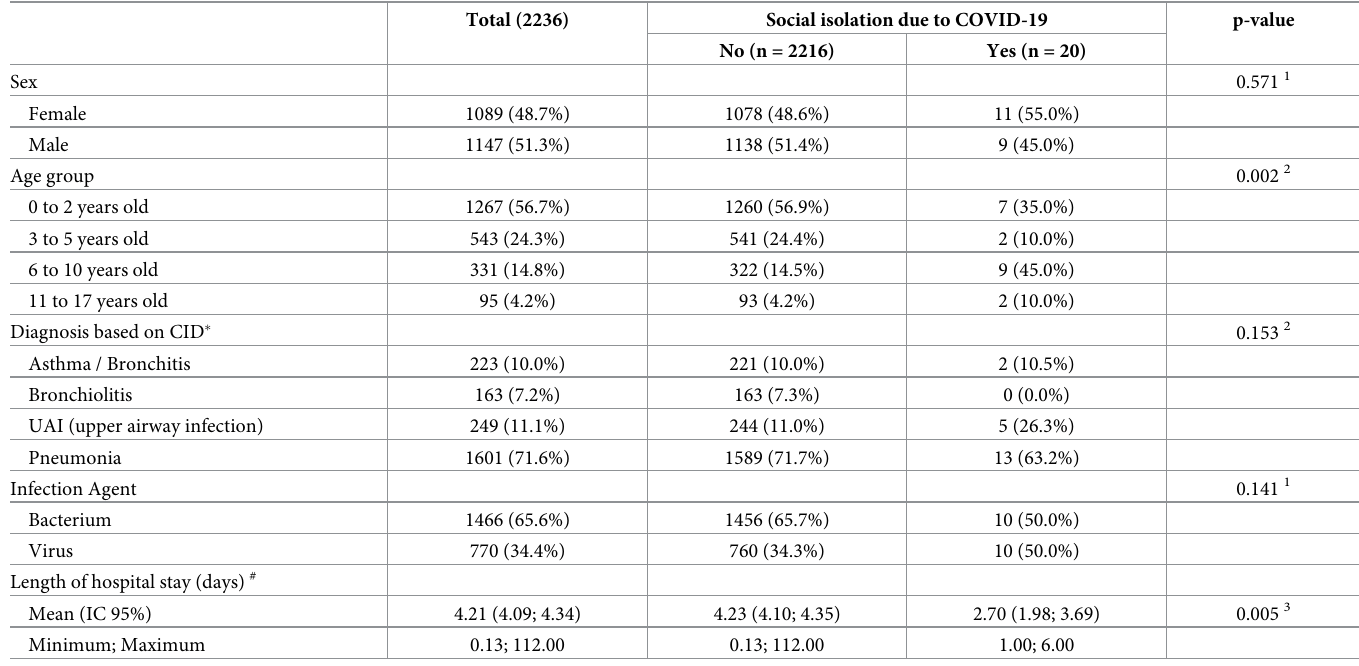
Table 2. Characteristics of pediatric patients admitted for respiratory diseases in the period from January 2015 to June 2020 (n =